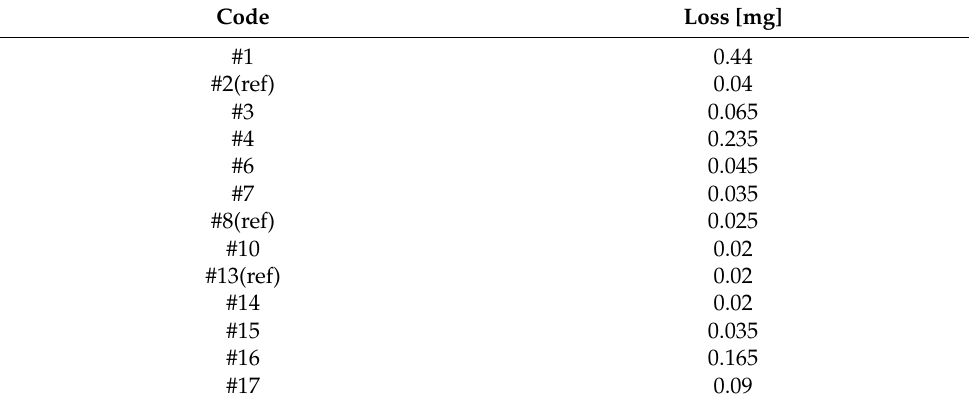
Table 5. Average mass loss (mg) calculated for each hypotube.